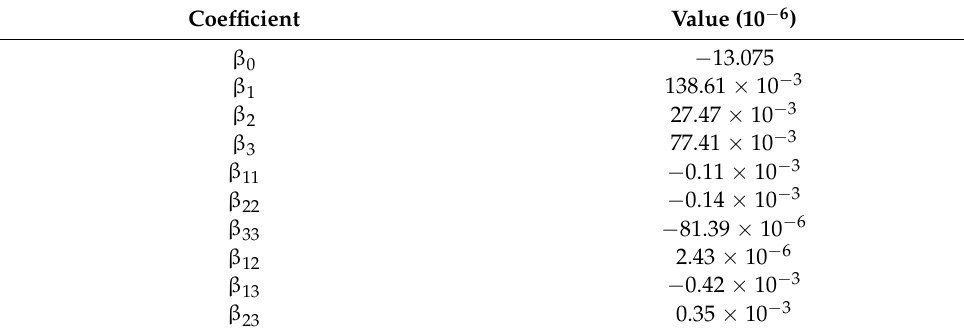
Table 9. Regression coefficients for flexural